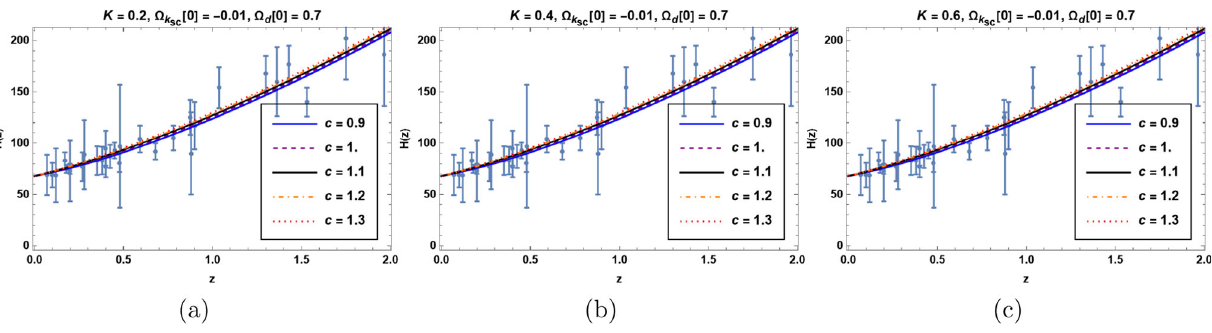
Fig. 10 The variation in the Hubble parameter H with redshift z for the open universe, in units when M 2 p = 1 , H 0 = 67 . 9. In order to be consistent with data, we now imposed (cid:2) d ( x = − ln ( 1 + z ) = 0 ) = (cid:2) d [ 0 ] = 0 . 7. Bars represent the 30 H ( z )